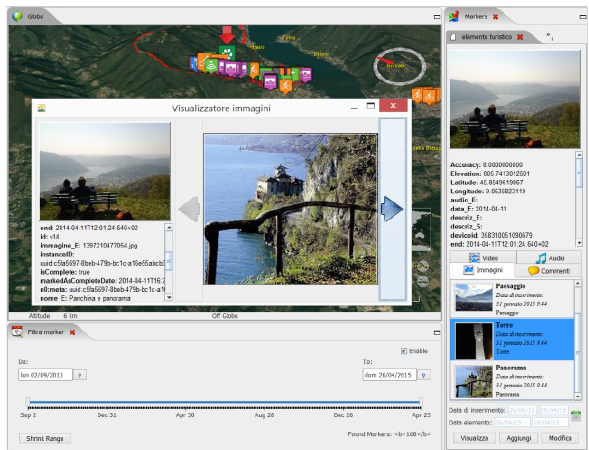
Figure 9. Marker icons thematization by